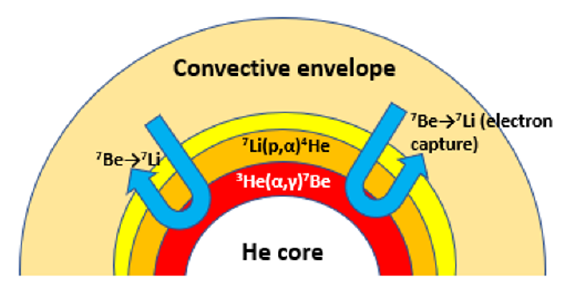
Figure 2. A schematic picture on the lithium enhancement. The figure is not to